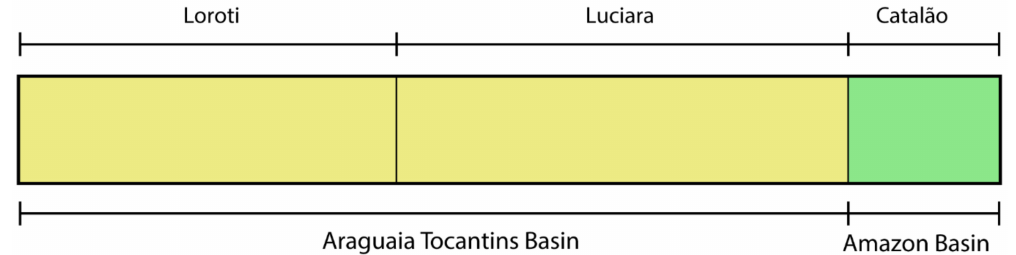
Figure 5. FastStructure and Geneland analysis of O. bicirrhosum samples, that had a congruent result returning K = 2. Each vertical bar represents an individual and its color represent the proportion of belonging to each population. Black bars separate sampling locations.